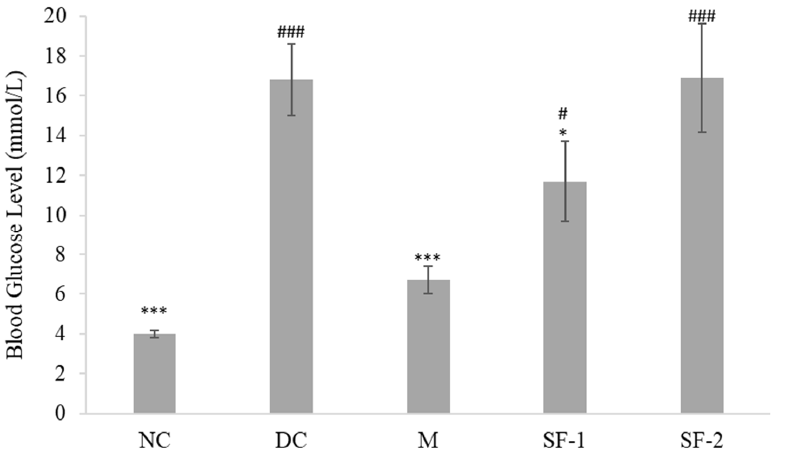
Figure 2. Effects of the subfractions of S. polyanthum ‘s chloroform fraction on the blood glucose levels of streptozotocin-induced diabetic rats after being treated orally twice daily for six days. NC, normal control (normal saline, 10 mL/kg); DC, diabetic control (normal saline, 10 mL/kg); M, metformin (500 mg/kg); SF-1, subfraction-1 (250 mg/kg); SF-2, subfraction-2 (250 mg/kg). The values are expressed as mean ± SEM ( n = 6). # indicates significant differences as compared to the NC ( ### p < 0.001 and # p < 0.05). * indicates significant differences compared to the DC (*** p < 0.001 and * p < 0.05) as analyzed using Dunnett’s as post hoc test.